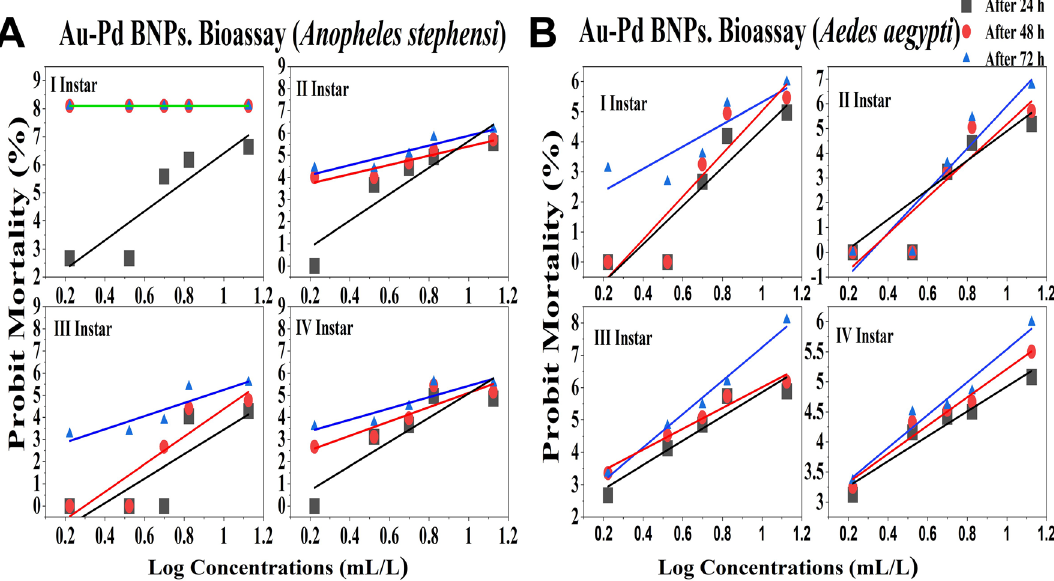
Figure 9. Probit regression plots generated from the Au–Pd BNPs bioassay data for I–IV instar larvae after 24 h, 48 h and 72 h of exposure of the Au–Pd BNPs test concentrations for: ( A ) larvae of Anopheles stephensi mosquito; ( B ) larvae of Aedes aegypti mosquito.